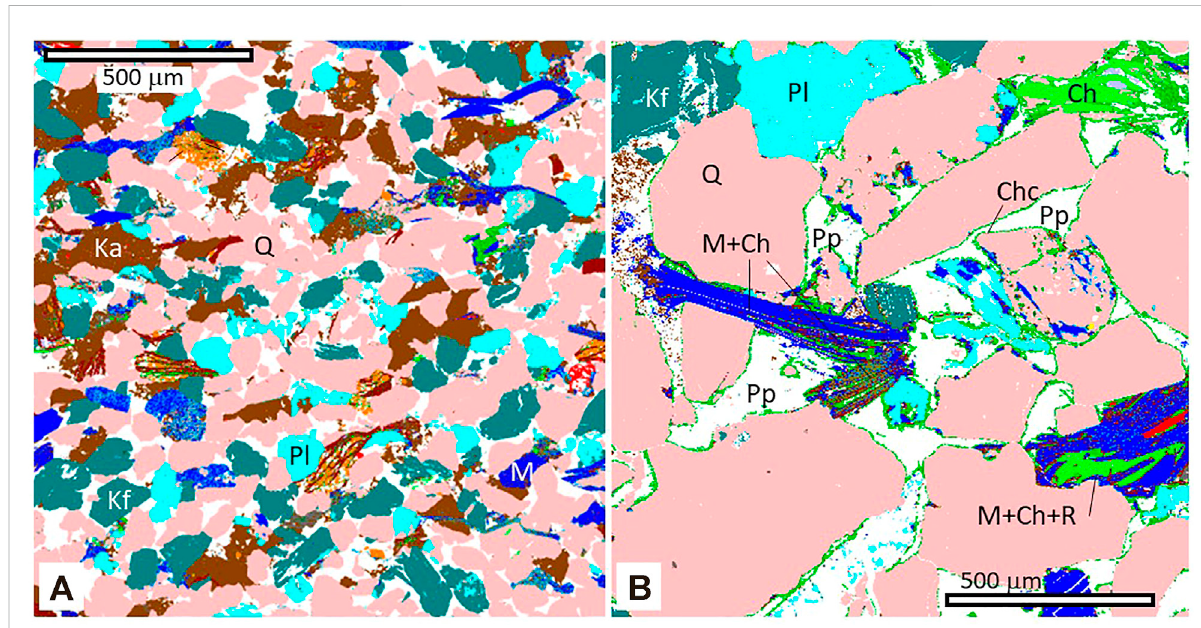
FIGURE 6 Muscovite and detrital chlorite fabrics in sandstones (mineral colour index in Figure 3). (A) Mid Jurassic lower shoreface sandstone from the North Viking Graben in the North Sea Basin with abundant quartz (Q), plagioclase (Pl), K-feldspar (Kf), and muscovite (M) grains. This sandstone contains (12%) primary porosity (Pp). Patches of kaolinite (Ka) are a similar size to grains suggesting the kaolinite has replaced a detrital mineral, such as feldspar. Muscovite (M) grains have bent around more rigid grains during mechanicalcompaction. (B) Lower Jurassic deltaic sandstone from NorthSea,Norway,withquartz,K-feldspar,andplagioclasegrainsaswellascomplexintergrowthsofmuscoviteandchlorite(probablymetamorphic rockfragmentswithmuscovite:M,chlorite:Chandrutile:R).Sandgrainscontainchloritecoats(Chc).DetritalchloriteismoreMg-rich(lightergreen) than grain-coating chlorite (darker